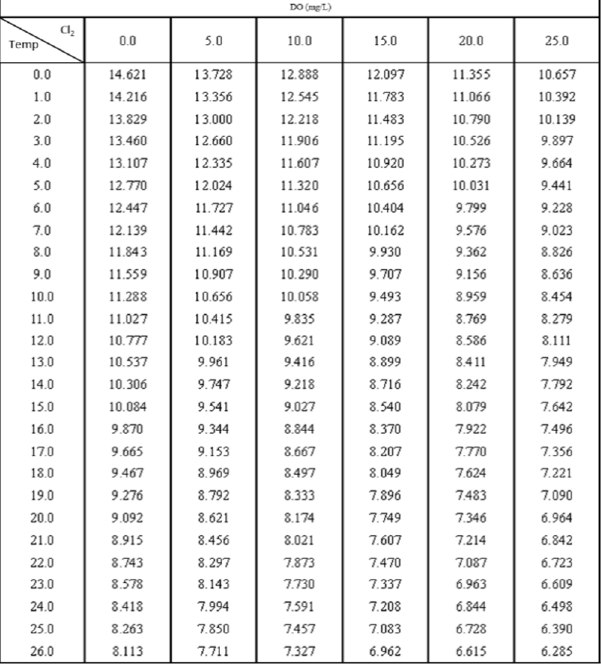
Figure 7. The relationship between temperature and saturated dissolved oxygen